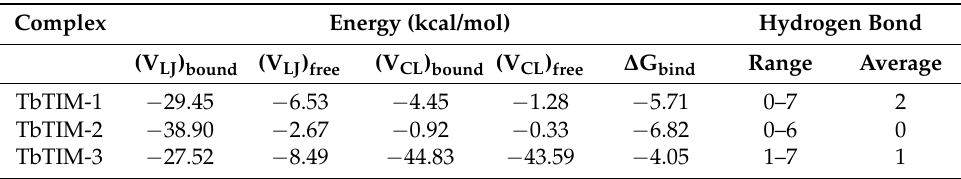
Table 1. Binding free energies calculated by the Linear Interaction Energy method and hydrogen bonds of the complexes during molecular dynamics. Complex Energy (kcal/mol) (V CL ) free ∆ G (V LJ ) bound (V LJ ) free